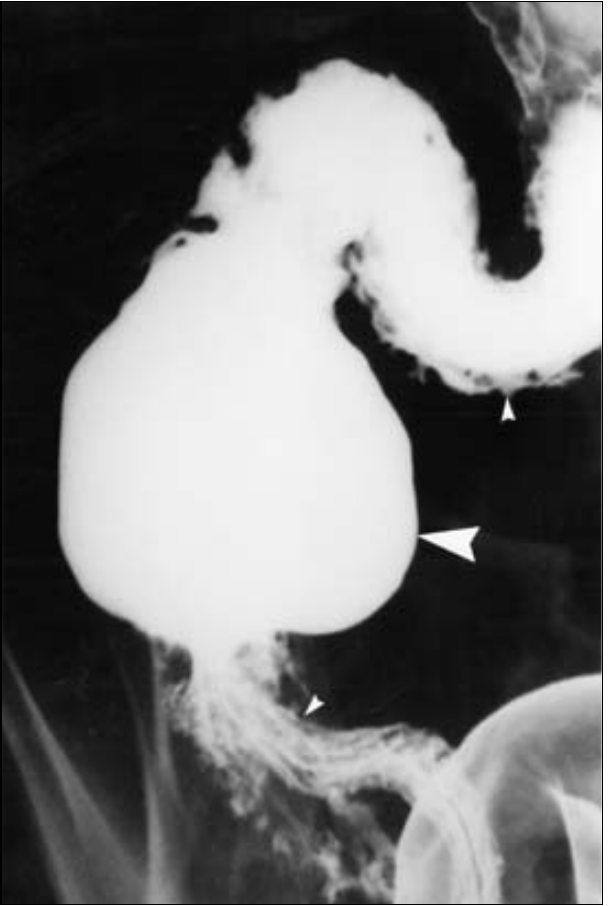
Figure 3) Double contrast barium enema showing two strictures with mucosal ulcerations (small arrowheads) in the ascending colon and hepatic flexure with a skip area in between (large